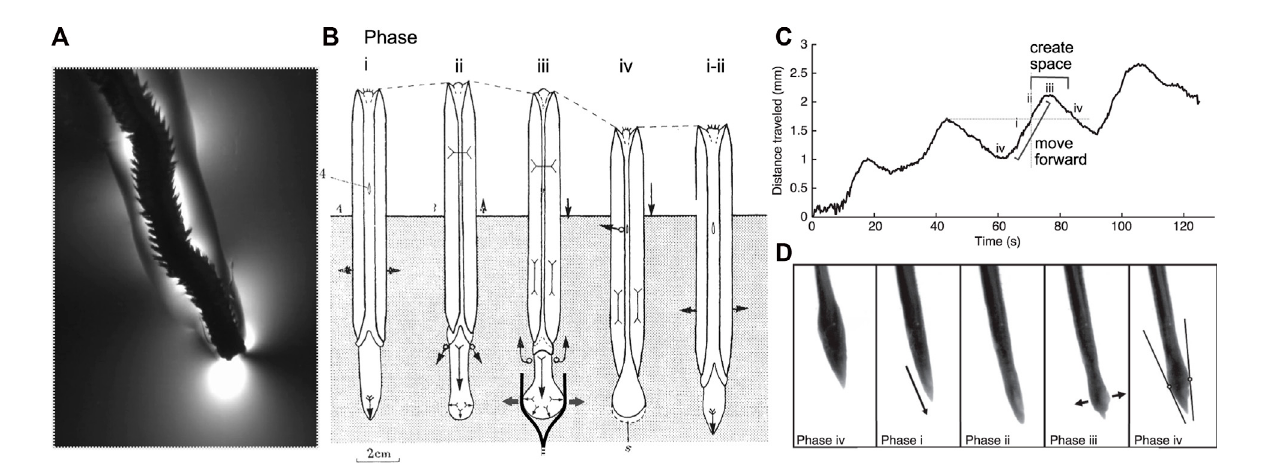
FIGURE 1 Burrowing by worms and clams uses similar mechanisms and phases of behaviors. (A) The polychaete Alitta virens extending a burrow by fracture in seawater gelatin (modi fi ed from Dorgan et al., 2007). Phases of burrowing cycles by (A) the razor clam, Ensis (Trueman 1968; Figure 4) and (B,C) the worm, Cirriformia (modi fi ed from Che and Dorgan 2010b; Figure 3) are consistent with this mechanism. (B) Schematic diagram of clam burrowing in sediment, showing alternating penetration anchor (phase i) and terminal anchor (phase iii-iv). (i) The shell expands to hold the body in place while the foot moves anteriorly, (ii) then the shell begins to close, expelling fl uid from the mantle cavity (black arrows) as the foot begins to dilate. (iii) The foot expands to create a terminal anchor, applyingforce to theburrow walls(gray arrows)that inmud wouldextend theburrow byfracture (as drawn)and insandwouldcreatealow- stress region in front of the foot. The shell is pulled forward, and additional fl uid expelled from the mantle cavity reduces friction with the burrow wall. (iv) The foot is relaxed and pulled backwards and the shell begins to expand to repeat the cycle. (Phase numbers were changed to match those described by Che and Dorgan, 2010a). (C) Distance travelled by Cirriformia moorei in gelatin, showing cyclic movement of the anterior of the worm. (D) Images of C. moorei burrowing in gelatin, with phases corresponding to those indicated in the graph in (C) and the description of Ensis in (B) . Circles in phase iv indicate contact points of the worm with the burrow wall, and the lines show the tangent to those points (see Che and Dorgan 2010b for more